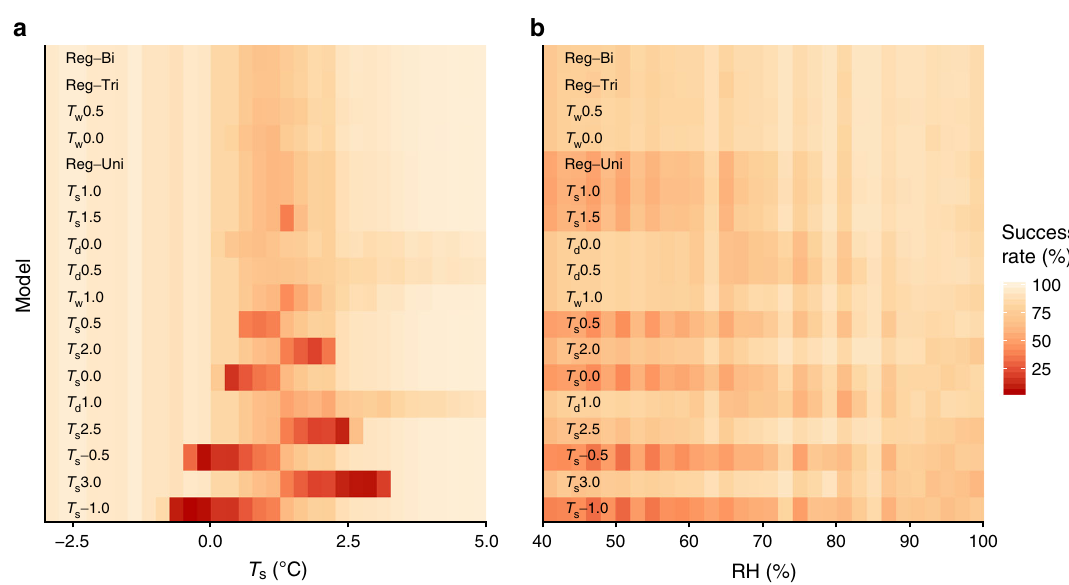
Fig. 4 Success rates for the different precipitation phase methods ordered by average success rate with the best performing methods at the top. The success rate value is equal to the percentage of precipitation phase observations correctly simulated by the precipitation phase method. Low success rate values (dark red) correspond to a high frequency of misidenti fi ed precipitation phase observations. a Success rate plotted by T s . b Success rate plotted by RH. Details on the different methods and average success rates are available in Supplementary Table